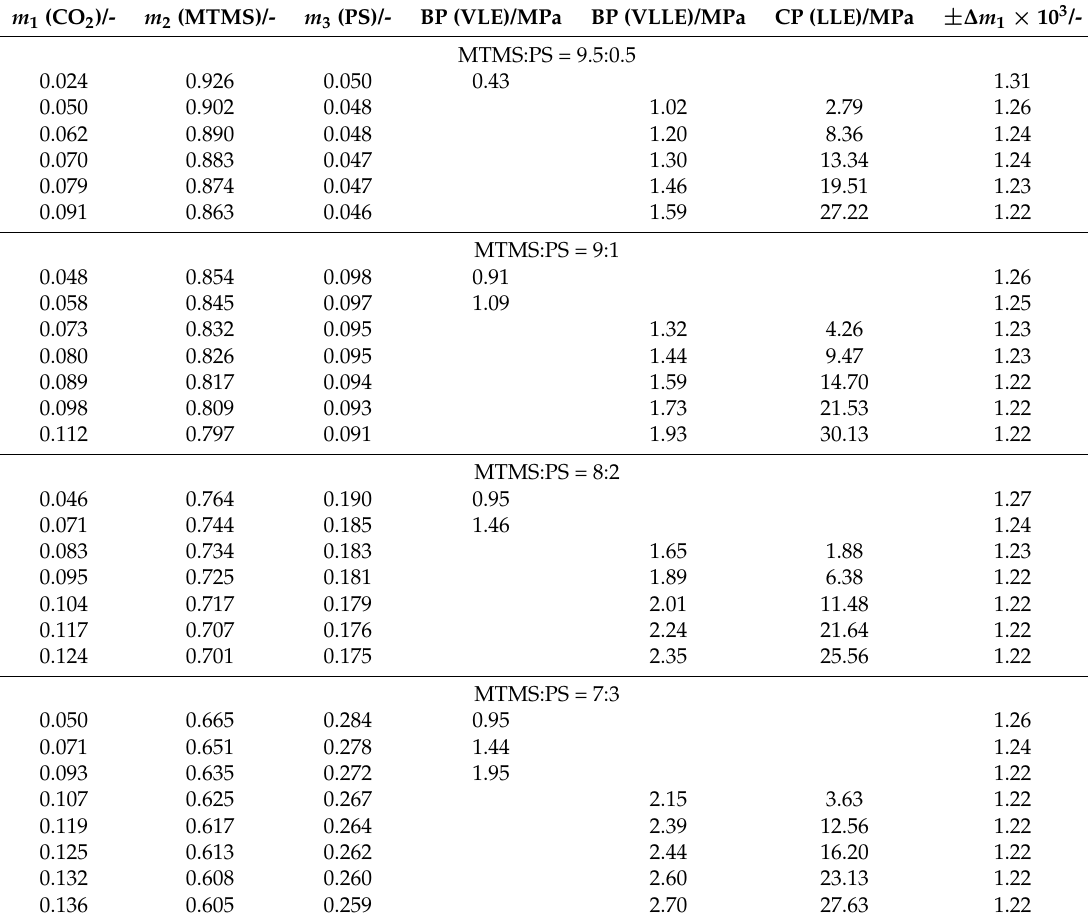
Table 2. Experimental data for a CO 2 (1)/MTMS(2)/PS(3) system (M W = 35,000, 313.2 K).